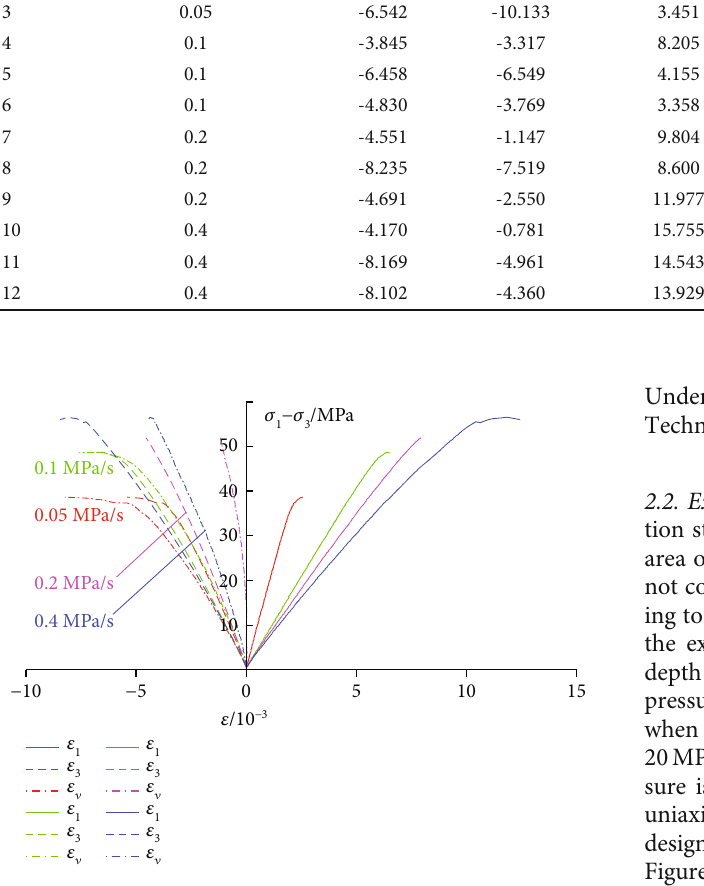
Figure 4: The stress-strain